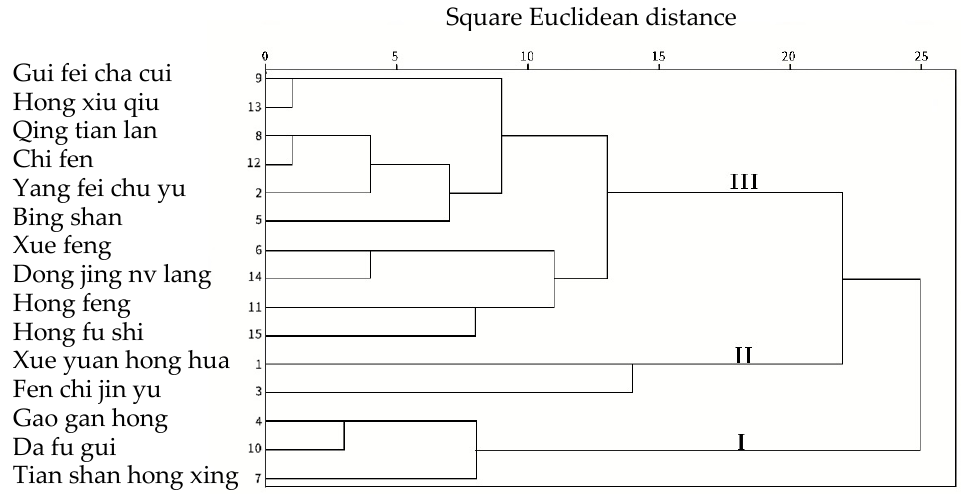
Figure 3. Clustering diagram of 15 varieties of Paeonia lactiflora.